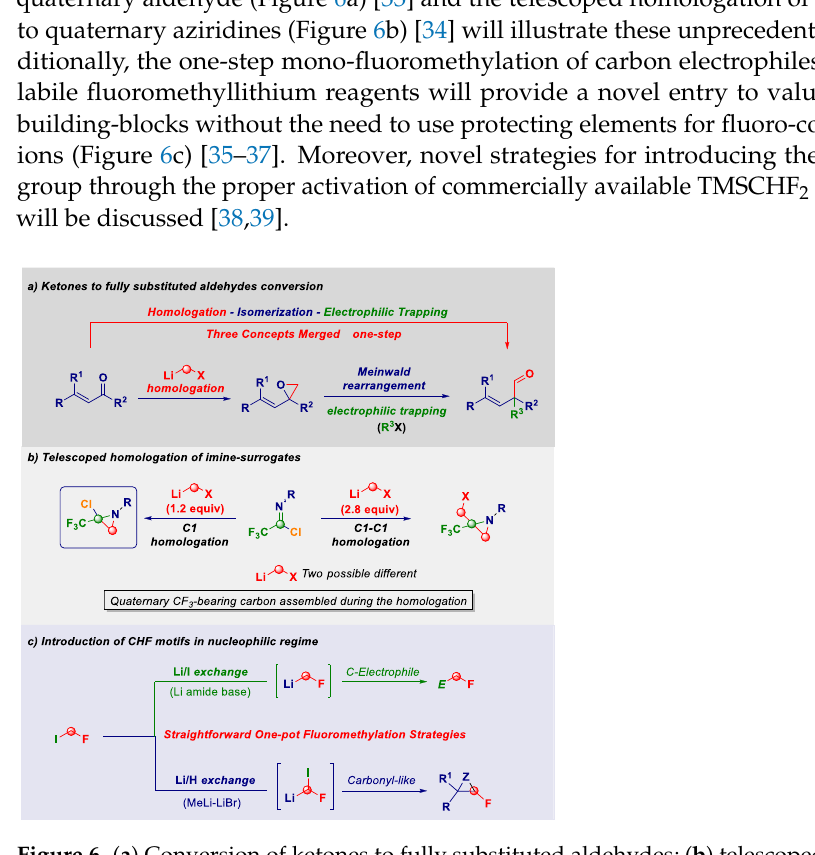
Figure 6. ( a ) Conversion of ketones to fully substituted aldehydes; ( b ) telescoped homologation of imine surrogates; ( c ) introduction of CHF motifs in nucleophilic regime.